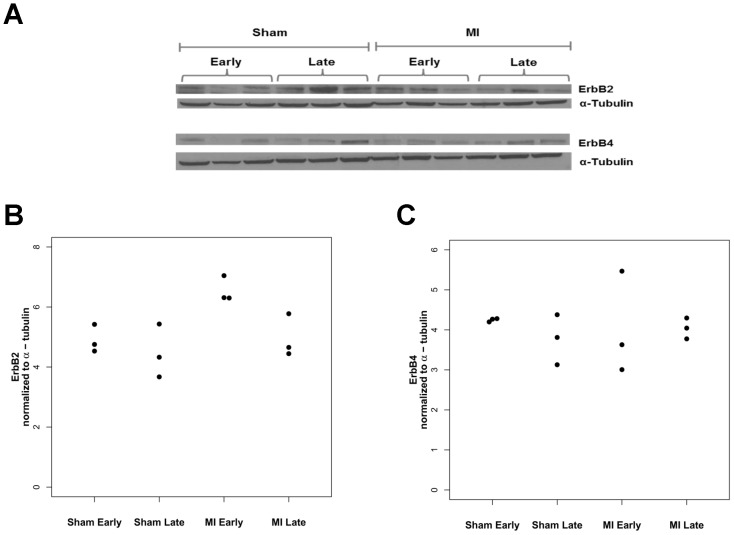
ErbB receptor protein expression in myocardium early and late after MI. A) Representative Western blot for ErbB2 and ErbB4 in early post-MI (5 weeks) vs late post-MI (12 weeks). B) Quantification of myocardial ErbB2 receptor expression after densitometric analyses. ErbB2 expression was normalized to α-tubulin expression for each of the groups. ErbB2 expression was increased early post MI compared to sham (p = 0.01) and late post MI (p = 0.03). C) Quantificationof myocardial ErbB4 receptor expression after densitometric analyses of blotted bands. Normalized ErbB4 expression to α-tubulin was similar in all groups.